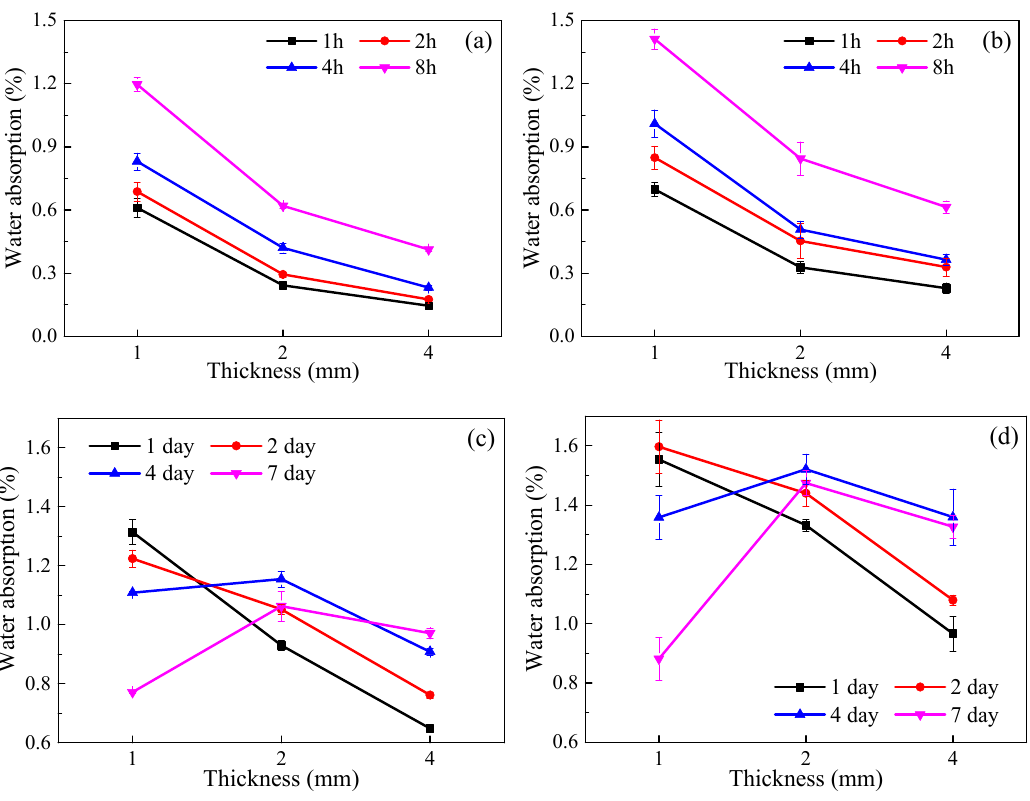
Figure 9. Variation of water absorption vs. specimen thickness soaked in ( a , c ) deionized water and ( b , d ) alkaline solution in early stage.